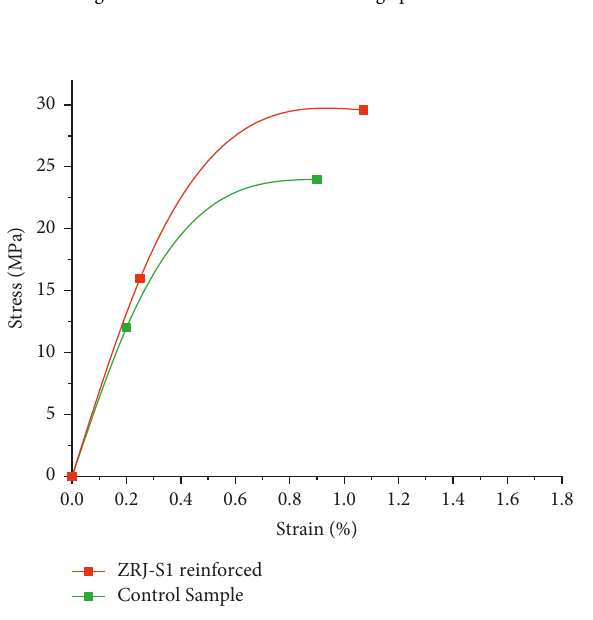
Figure 8: Comparison of triaxial stress–strain curve when ZRJ-S1 additives were